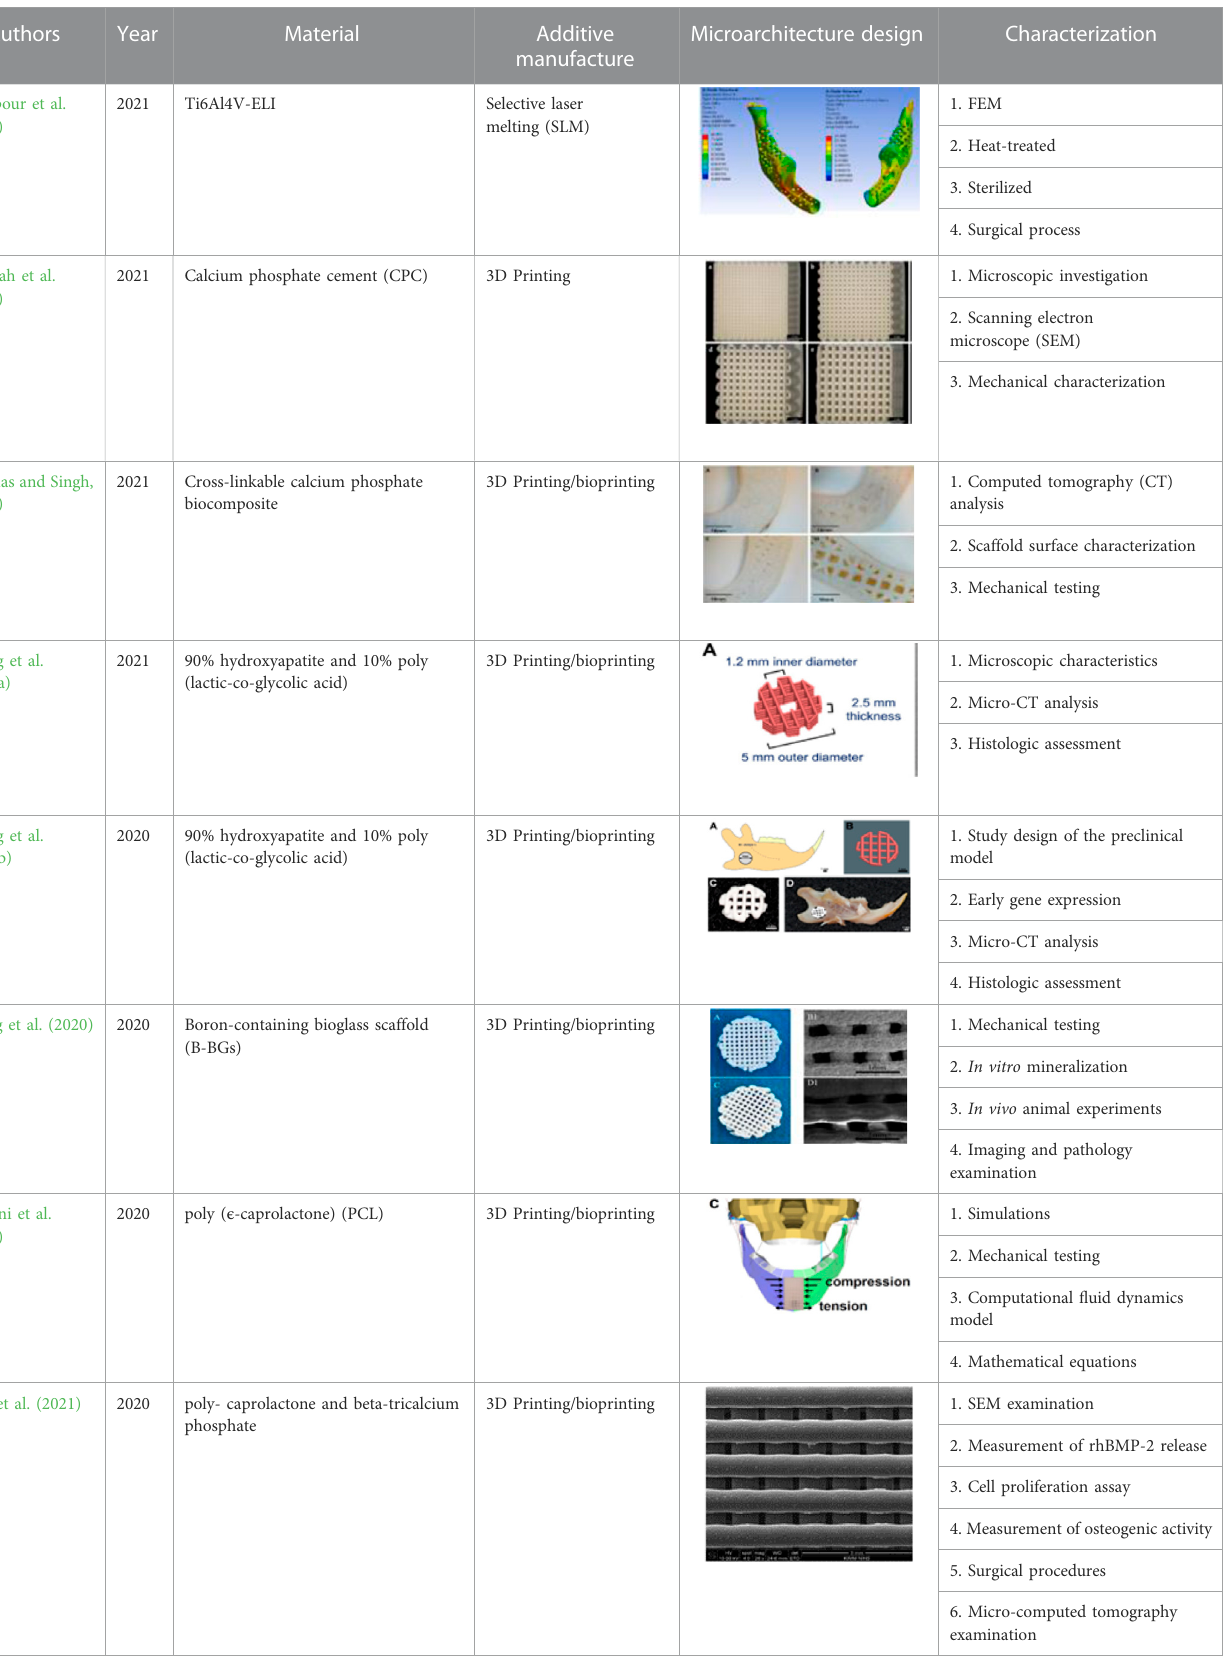
TABLE 3 Detailed information on each